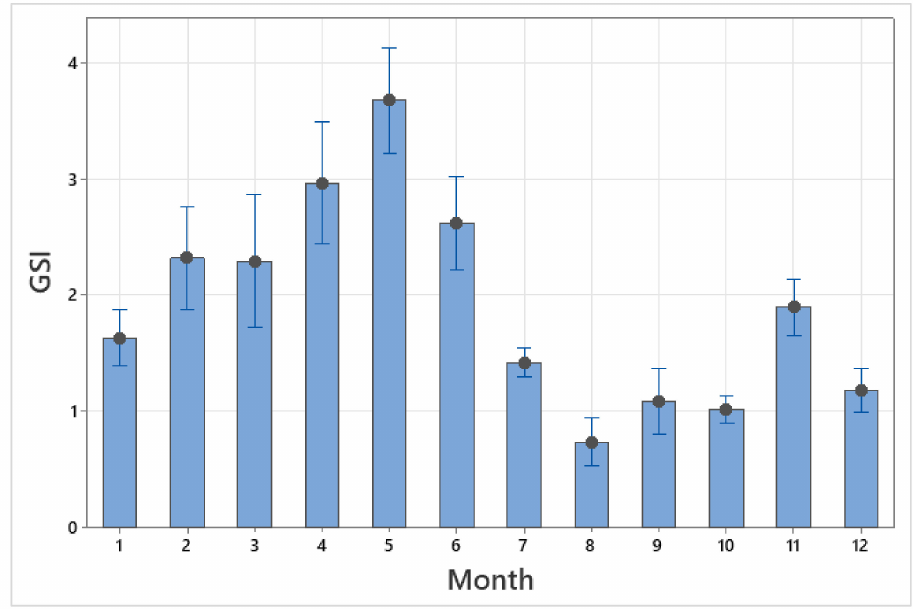
Figure 7. Interval plot of the gonadosomatic index for the total Arbacia lixula population sampled (each interval displays the monthly mean 95% confidence